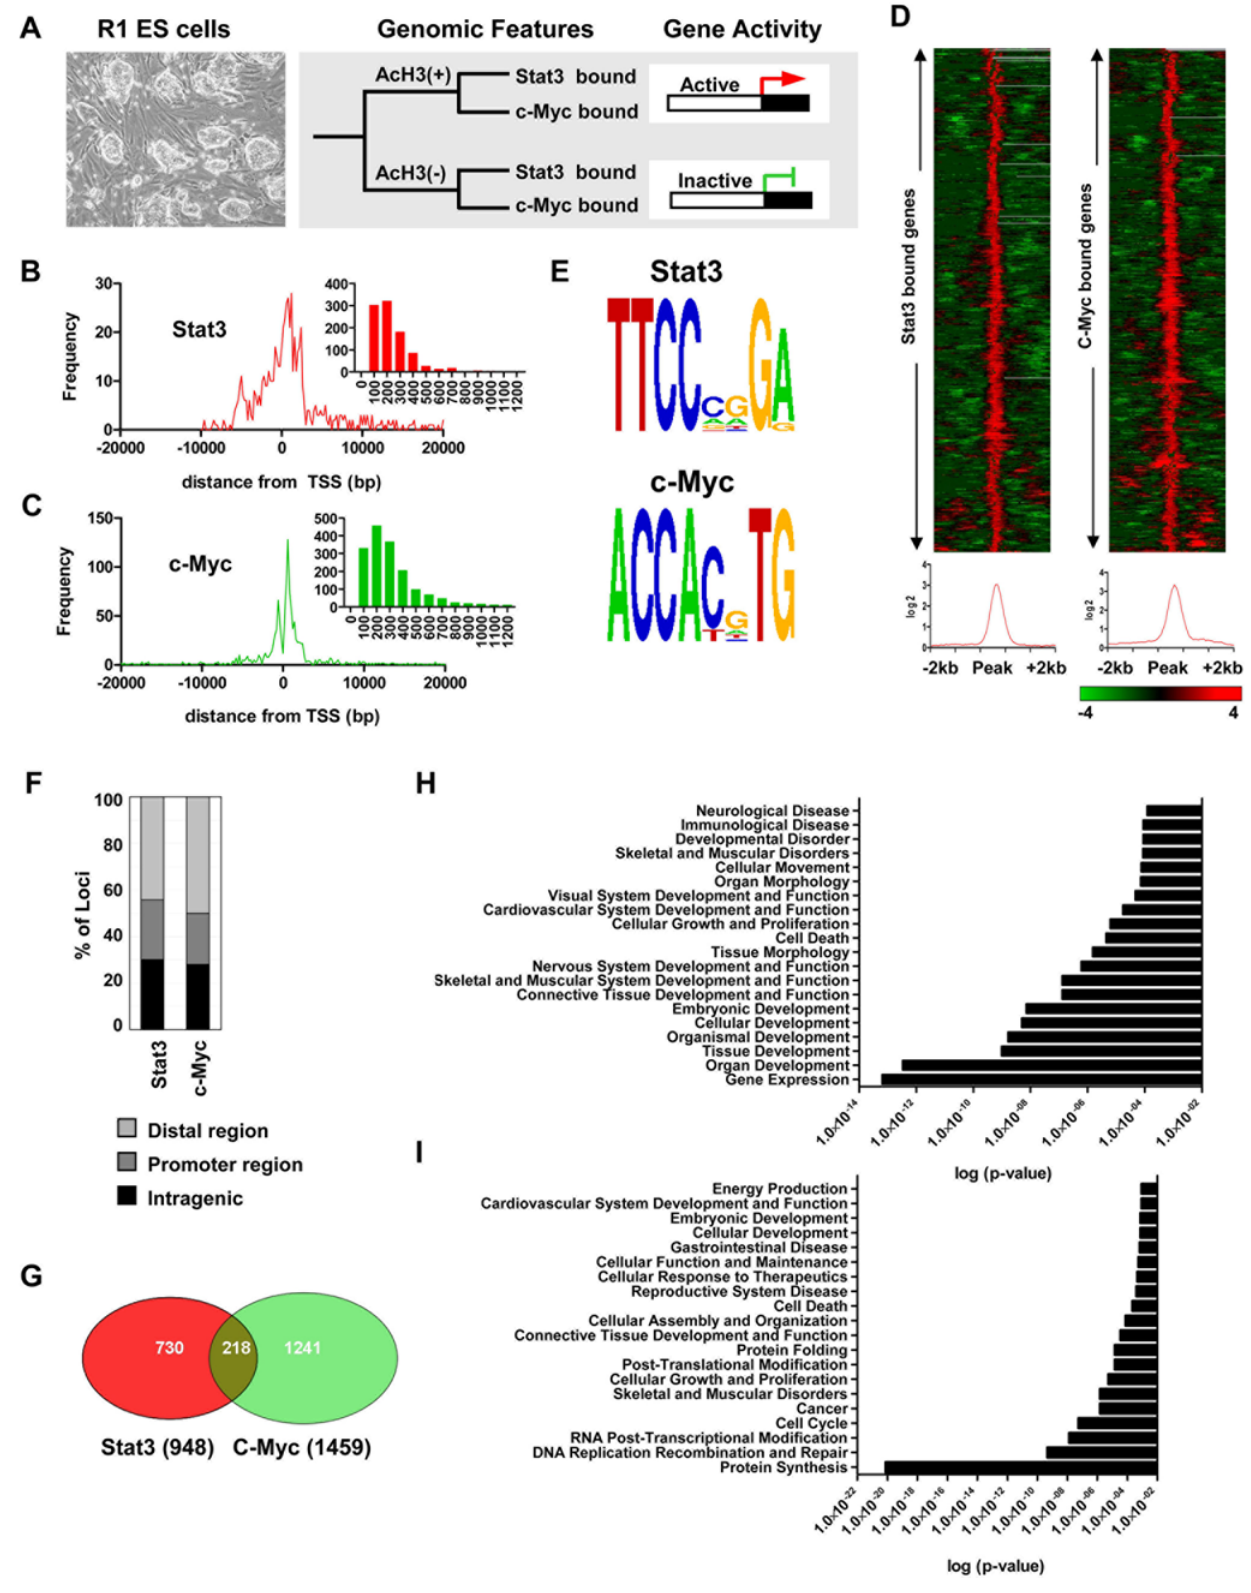
Figure 1. Genome-wide analysis of Stat3 and c-Myc binding in ES cells. (A) Experimental design. See methods and text for details. ChIP-chip analysis was used to map Stat3 and c-Myc genomic binding and regions of AcH3. Genes with AcH3 marks were considered actively transcribed. Distribution of (B) Stat3 and (C) c-Myc binding regions relative to the nearest transcription start site (TSS) of known genes. Inset graph shows length of (B) Stat3 and (C) c-Myc enriched DNA sequences. Y-axis represents frequency of binding and X-axis represents length of binding (bp). (D)